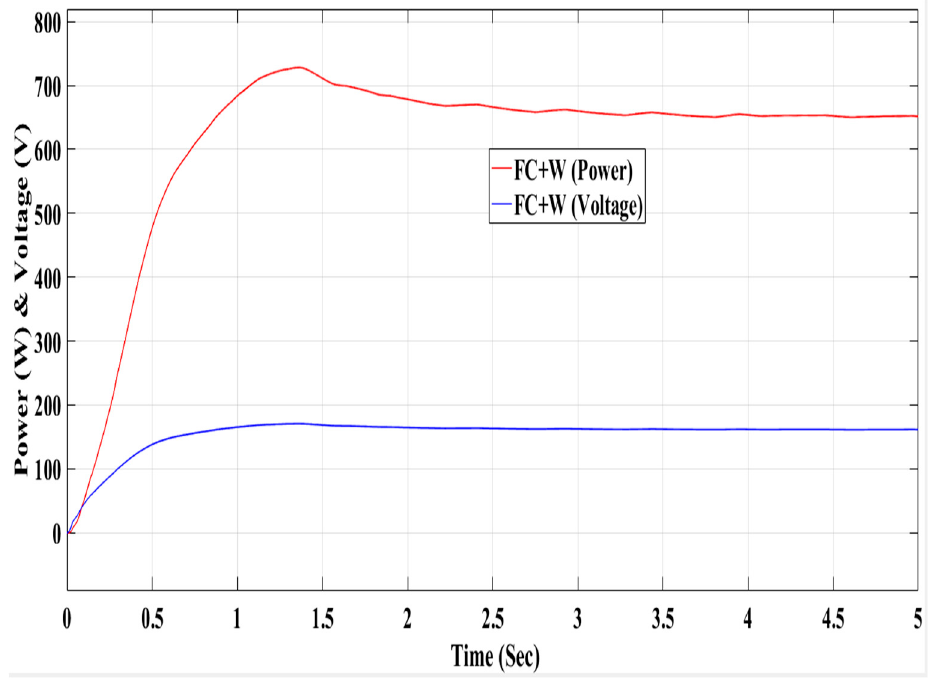
Figure 25. Power and voltage characteristics of the FC–W Model using the P&O-based MPPT method.